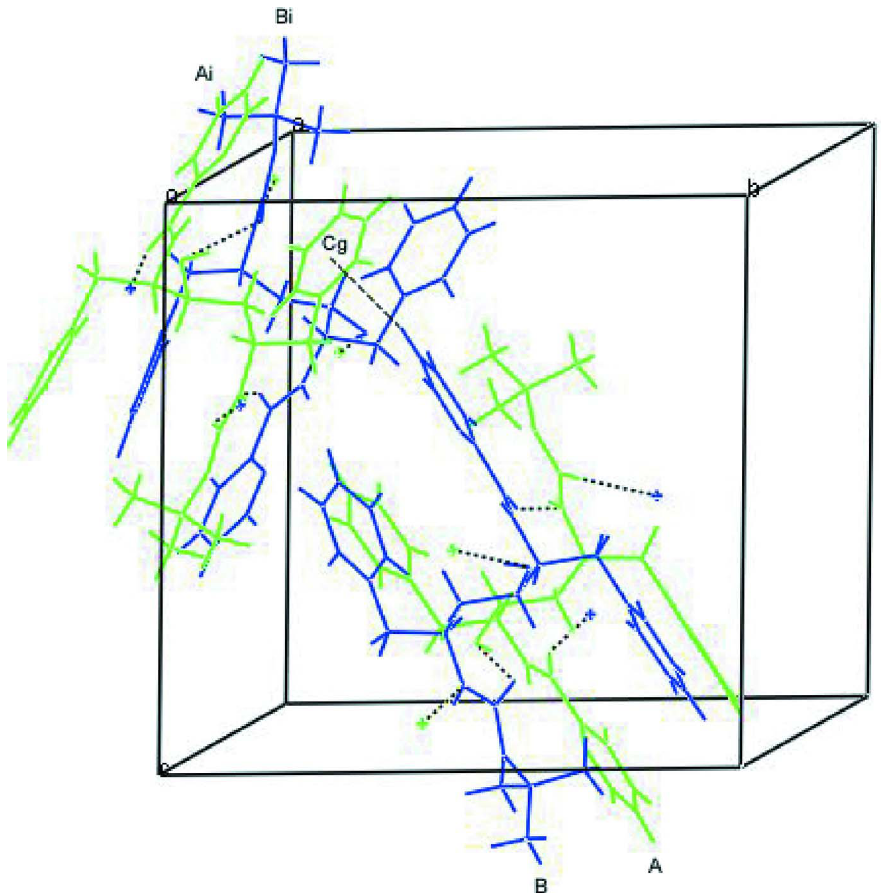
The packing of the molecules, viewed down the a axis. C—H··· π interactions and hydrogen bonds are shown as dashed lines. Cg is the centroid of the C6/C11 phenyl